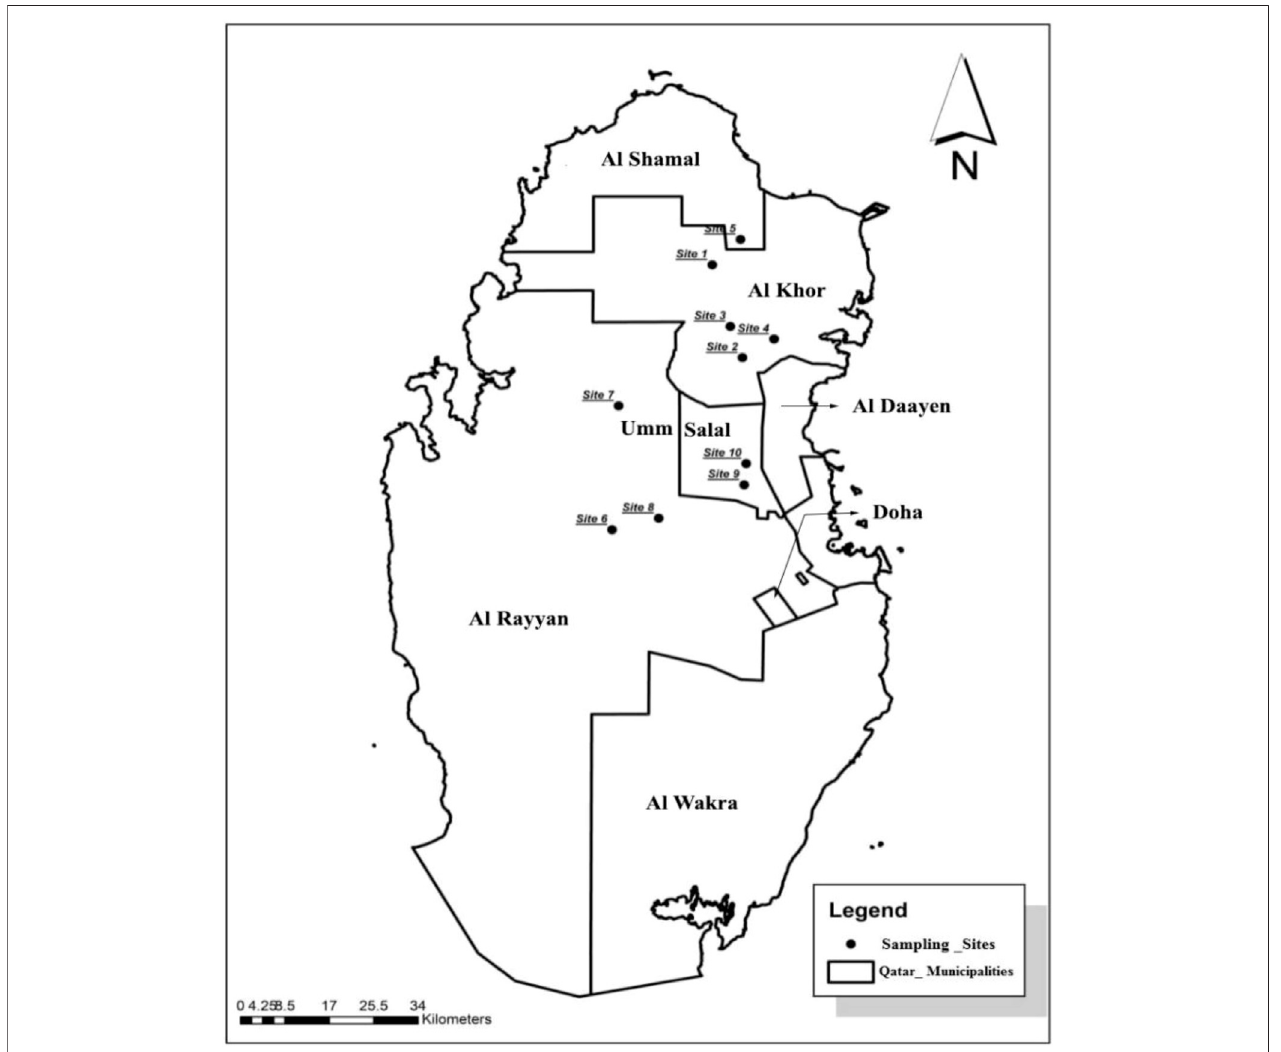
FIGURE 1 | Sampling